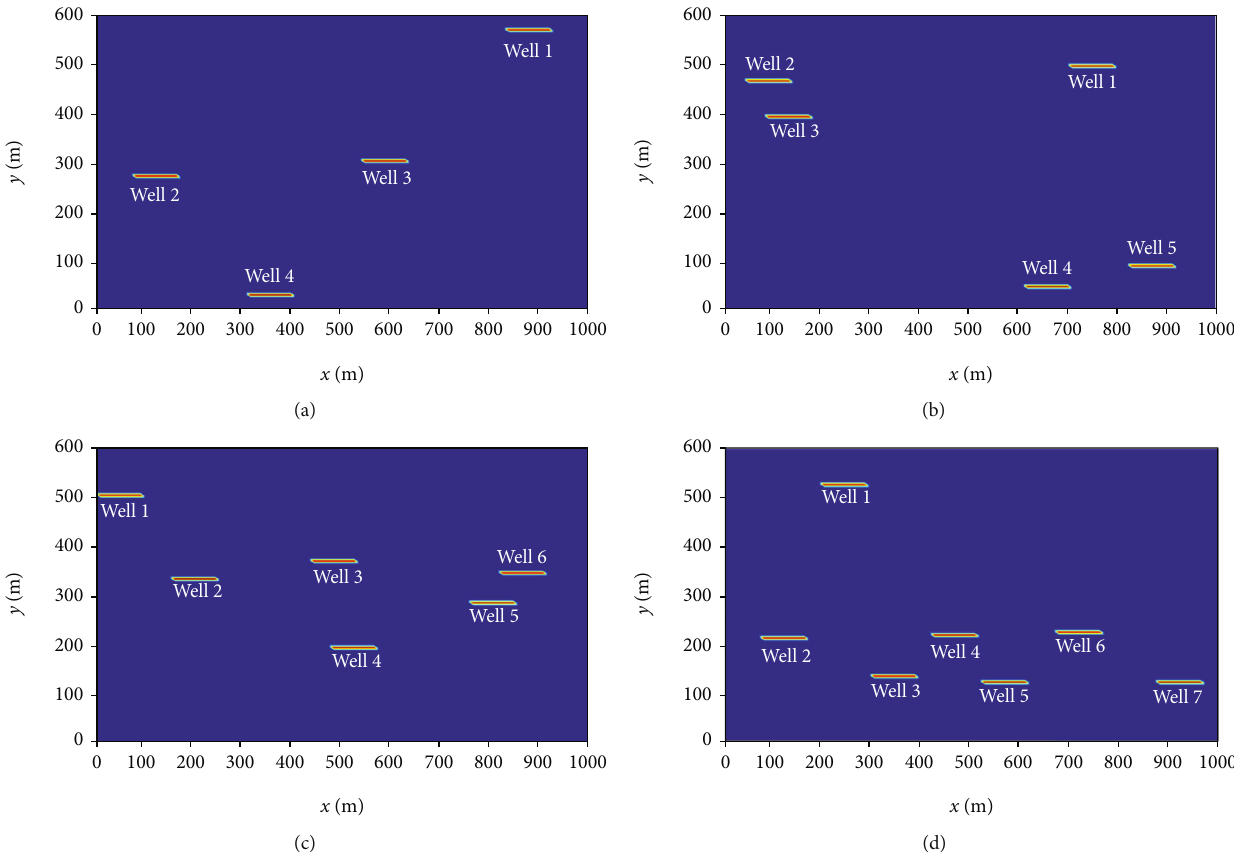
Figure 15: Distribution of the production wells: (a) 4 production wells, (b) 5 production wells, (c) 6 production wells, and (d) 7 production